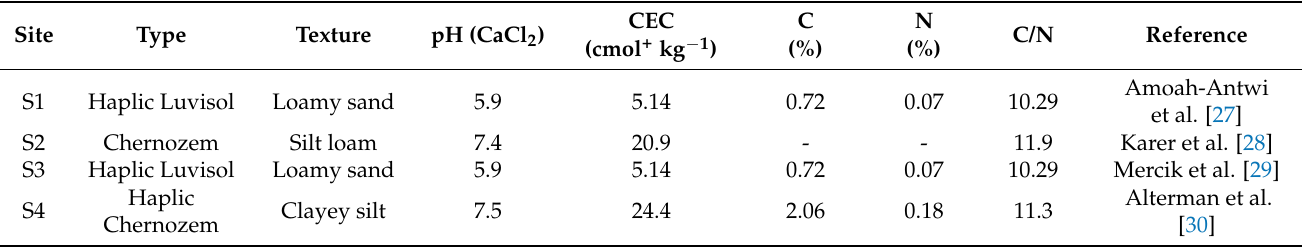
Table 1. Properties of soil at the experimental sites.